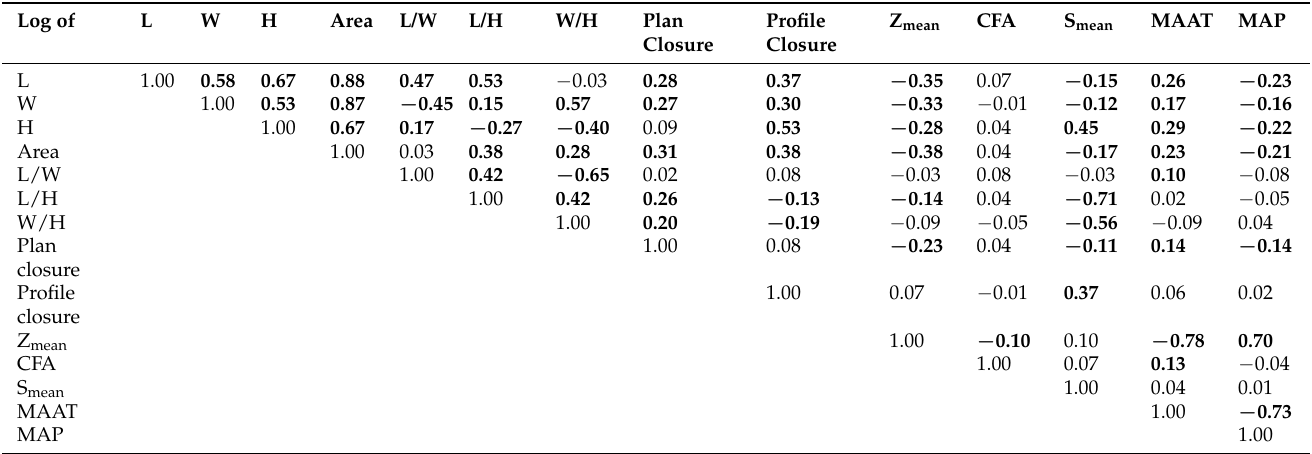
Table 2. Pearson’s r of the cirque metrics of the study area a . The correlations in bold are significant at the 0.05